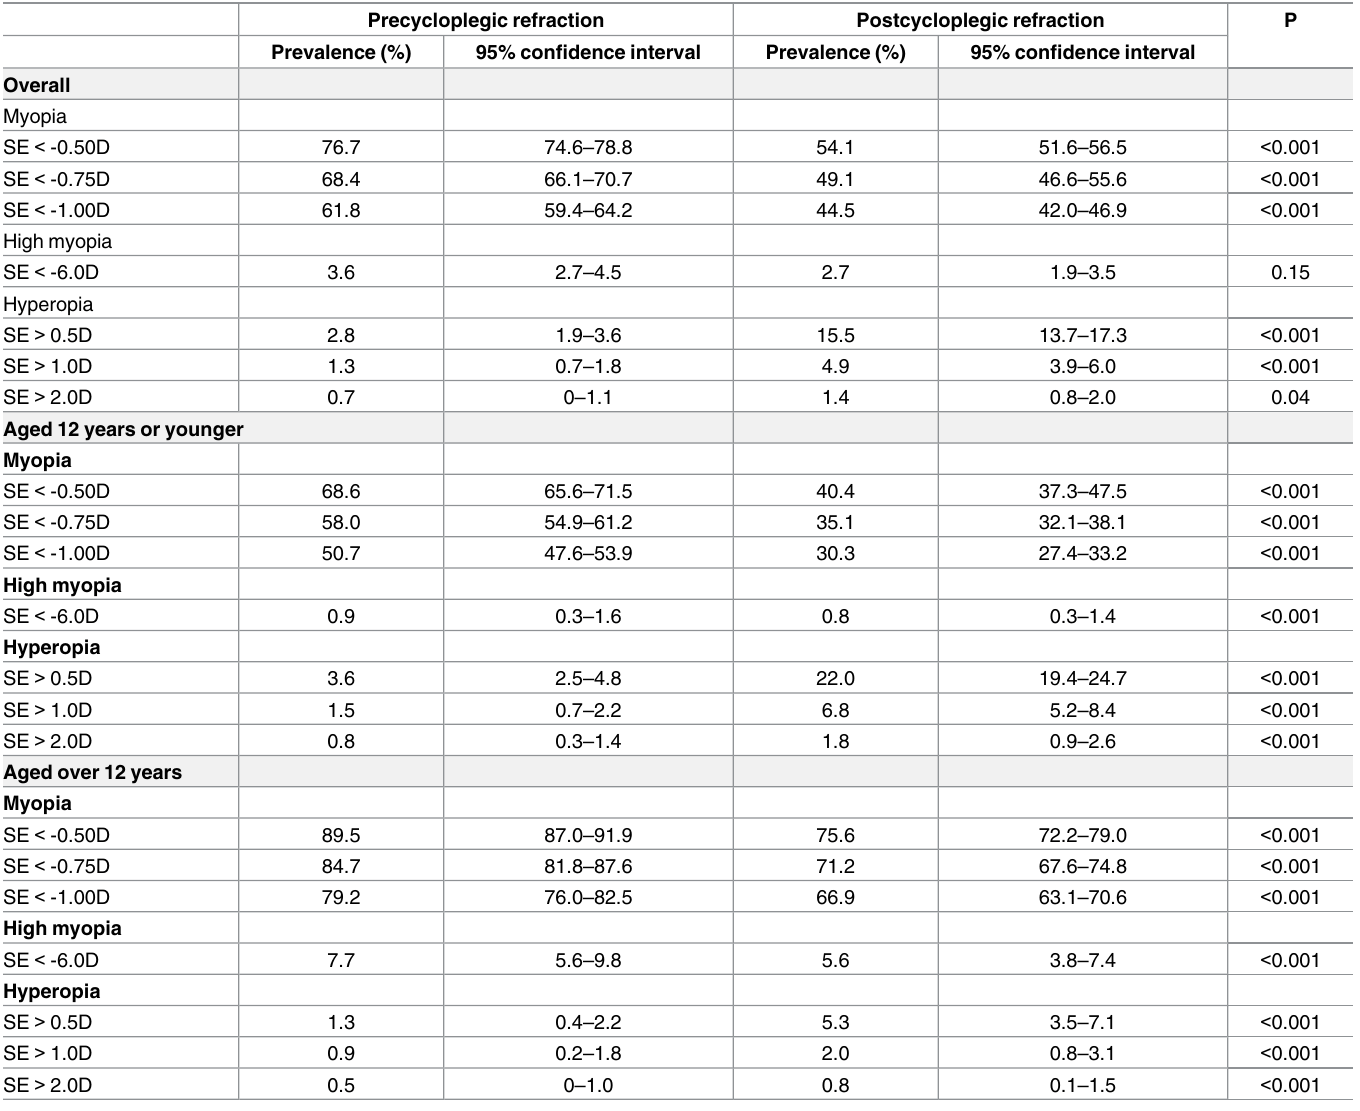
Table 2. Prevalence estimatesof refractiveerrors before and after cycloplegic